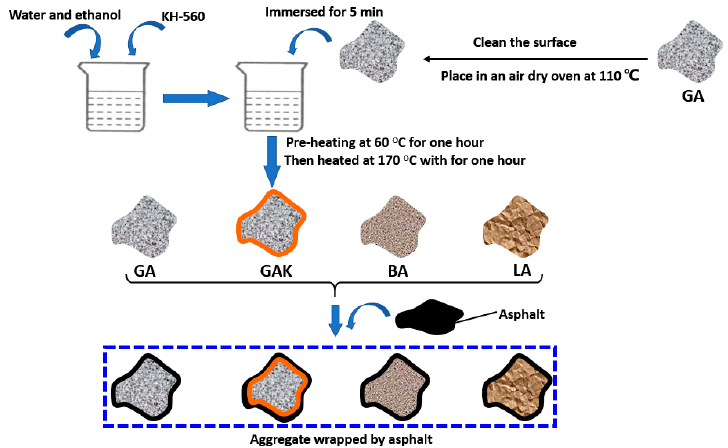
Figure 2. Schematic diagram of asphalt coated aggregate.